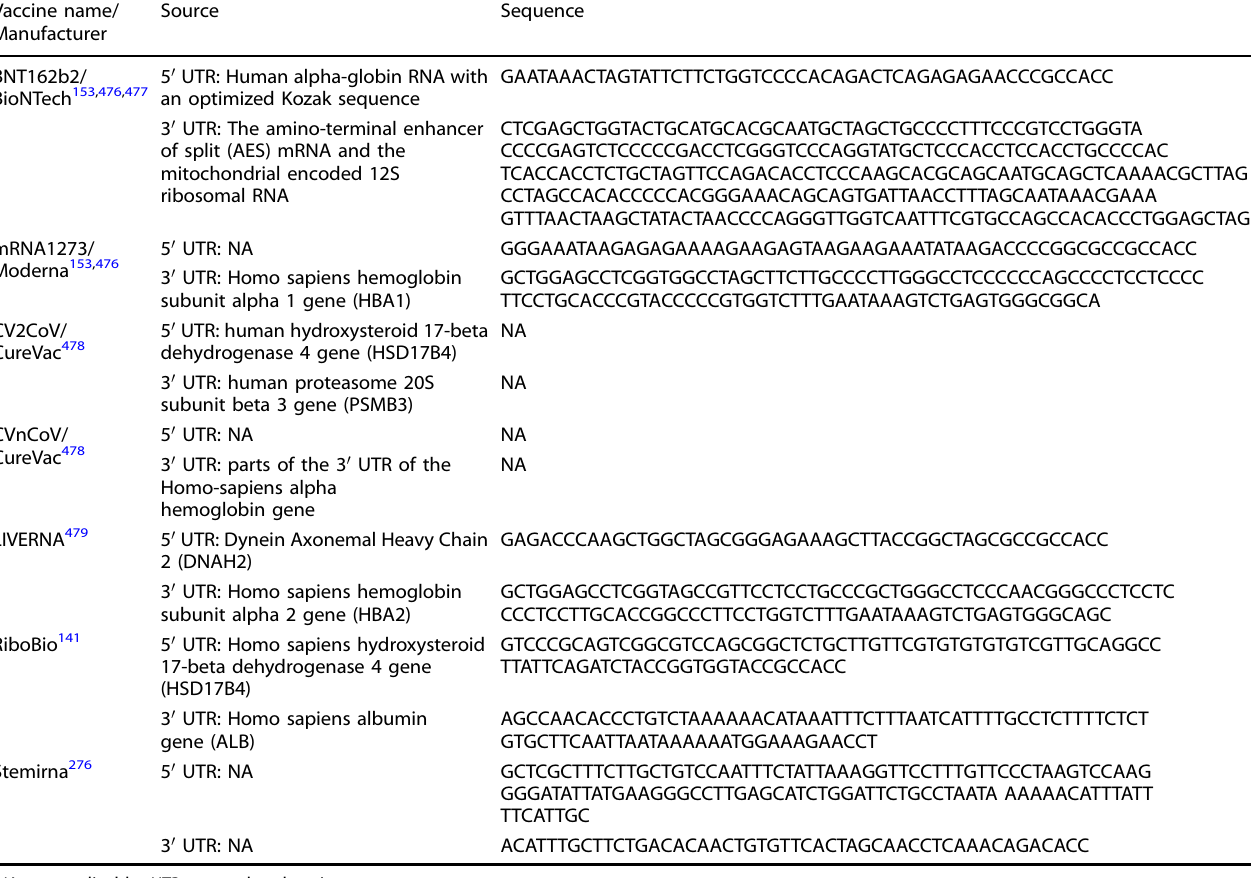
Table 1. Design strategies for 5 ′ and 3 ′ UTR of mRNA vaccines from different vaccine manufacturers and/or